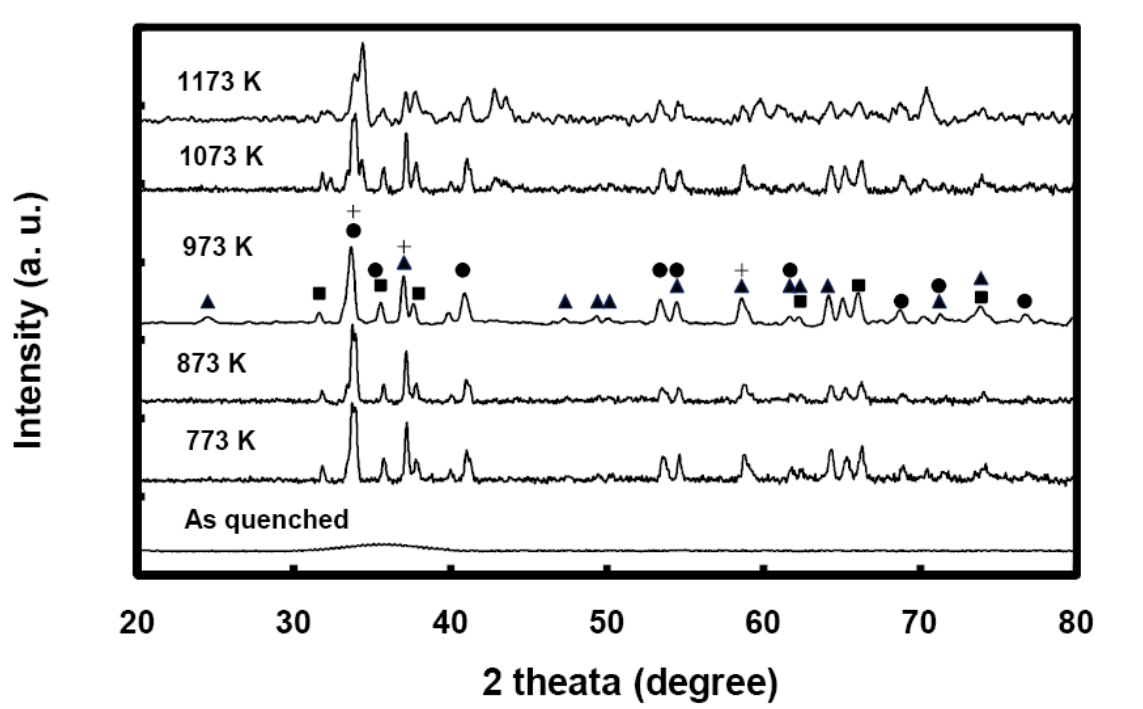
Figure 5. X-ray diffraction (XRD) profiles for different samples of Ni glass annealed over the temperature range 773 to 1173 K for a period of one